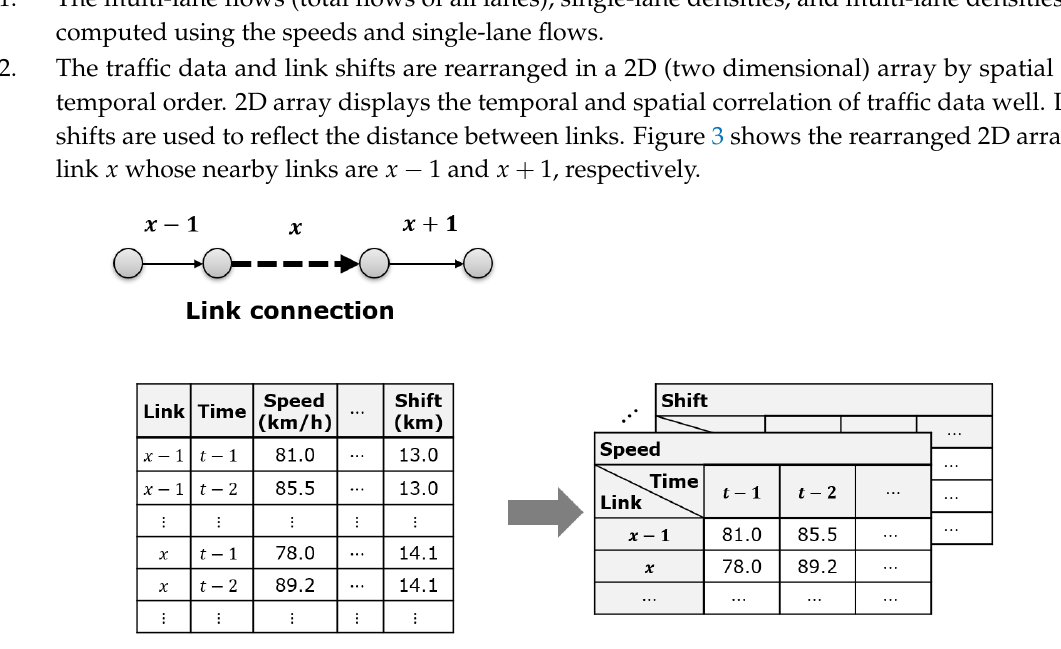
Figure 3. Rearrangement of traffic data into 2D